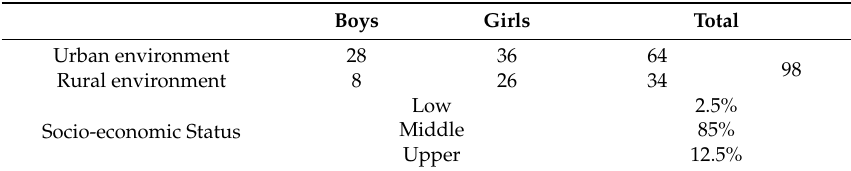
Table 1. Characteristics of the